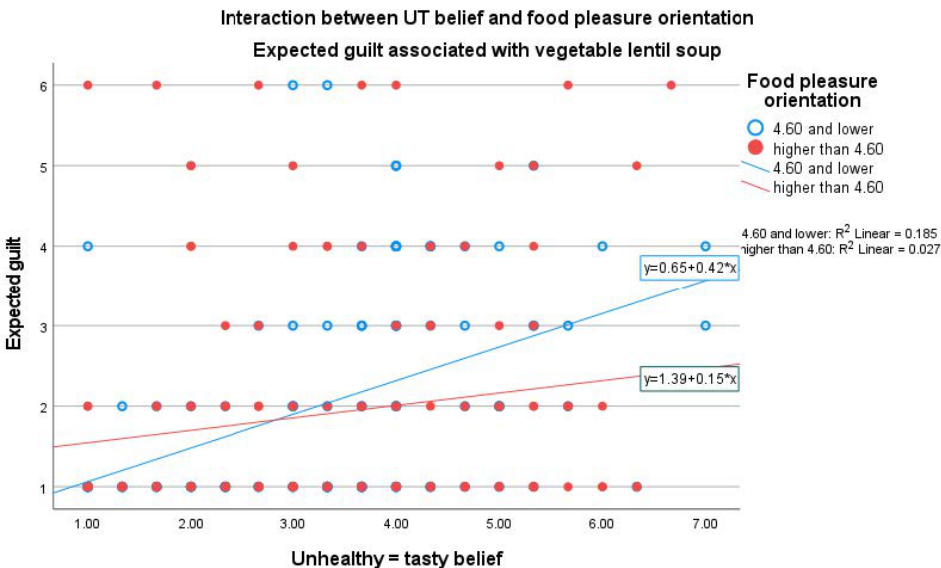
Figure 8. Interaction between UT belief and food pleasure orientation when rating expected guilt associated with the healthy product (vegetable lentil soup). Linear regression among lower food- pleasure-oriented participants: β = 0.418, p < 0.001, CI (95.0%): 0.258 – 0.578. Linear regression among higher food-pleasure-oriented participants: β = 0.154, p = 0.050, CI (95.0%): 0.000 – 0.309.